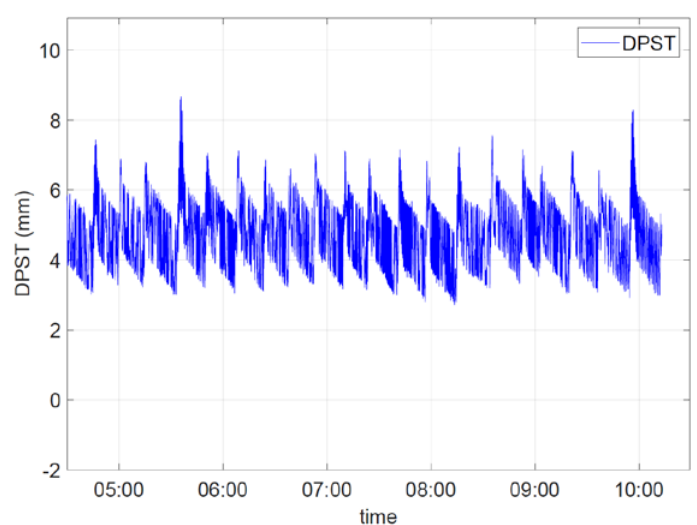
Figure 6. DPST vs. time.